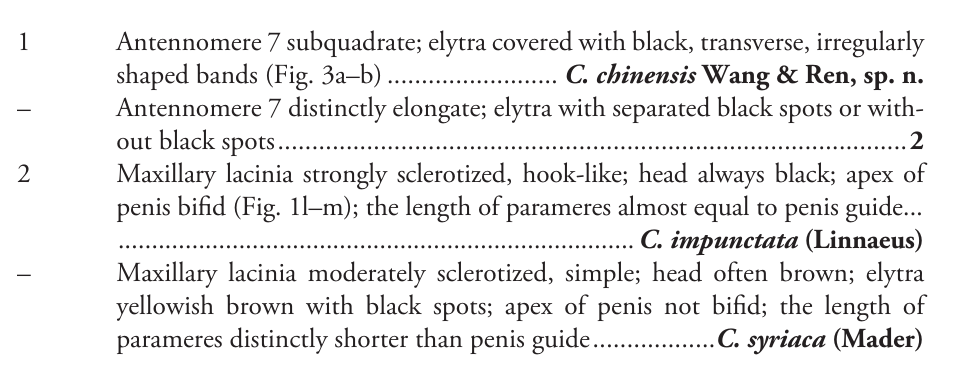
Diagnosis. This species is very similar to C. syriaca in general appearance and male genitalia but it can be distinguished from the latter as follow: antennomere 7 sub- quadrate, scutellum black, most of black spots on elytra joined, forming wavy shaped bands, coxites bearing distinct styli and the characters of penis capsule and penis